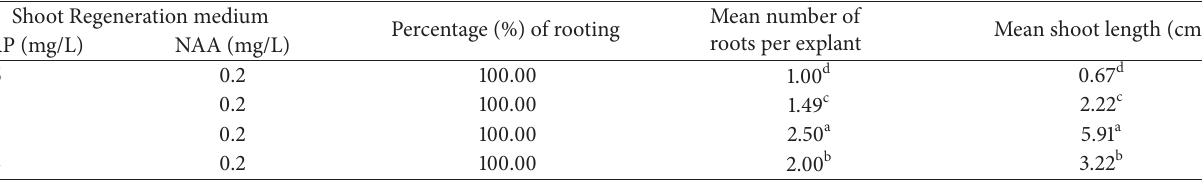
Table 2: Effects of various concentrations of regeneration medium on rooting on MS medium containing 0.2 mg/L NAA. Shoot Regeneration